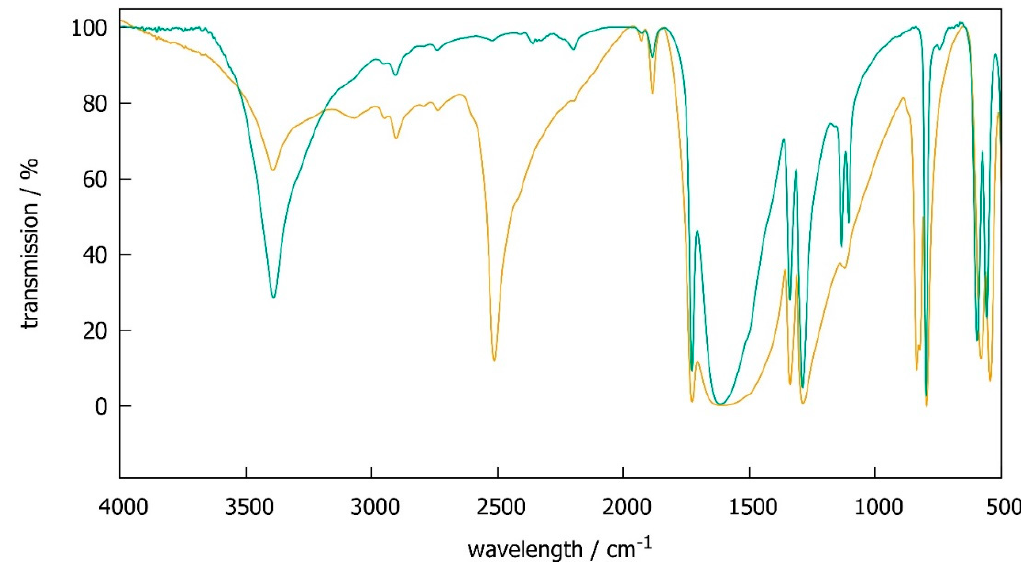
Figure 1. Infrared spectra of SbC 2 O 4 H (green) and SbC 2 O 4 OD (brown).